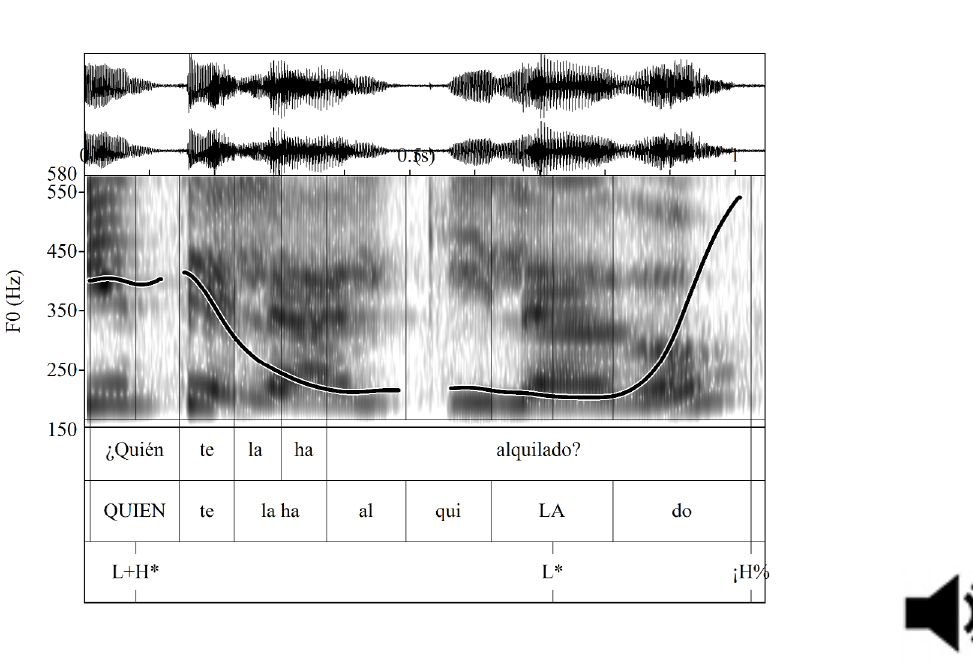
Figure 21 (Participant 10): Waveform and F0 trace for the neutral wh- question ¿ Quién te la ha alquilado? ‘Who has rented you the house?’ produced as L+H* (in prenuclear position) and L* ¡H% (nuclear configuration).